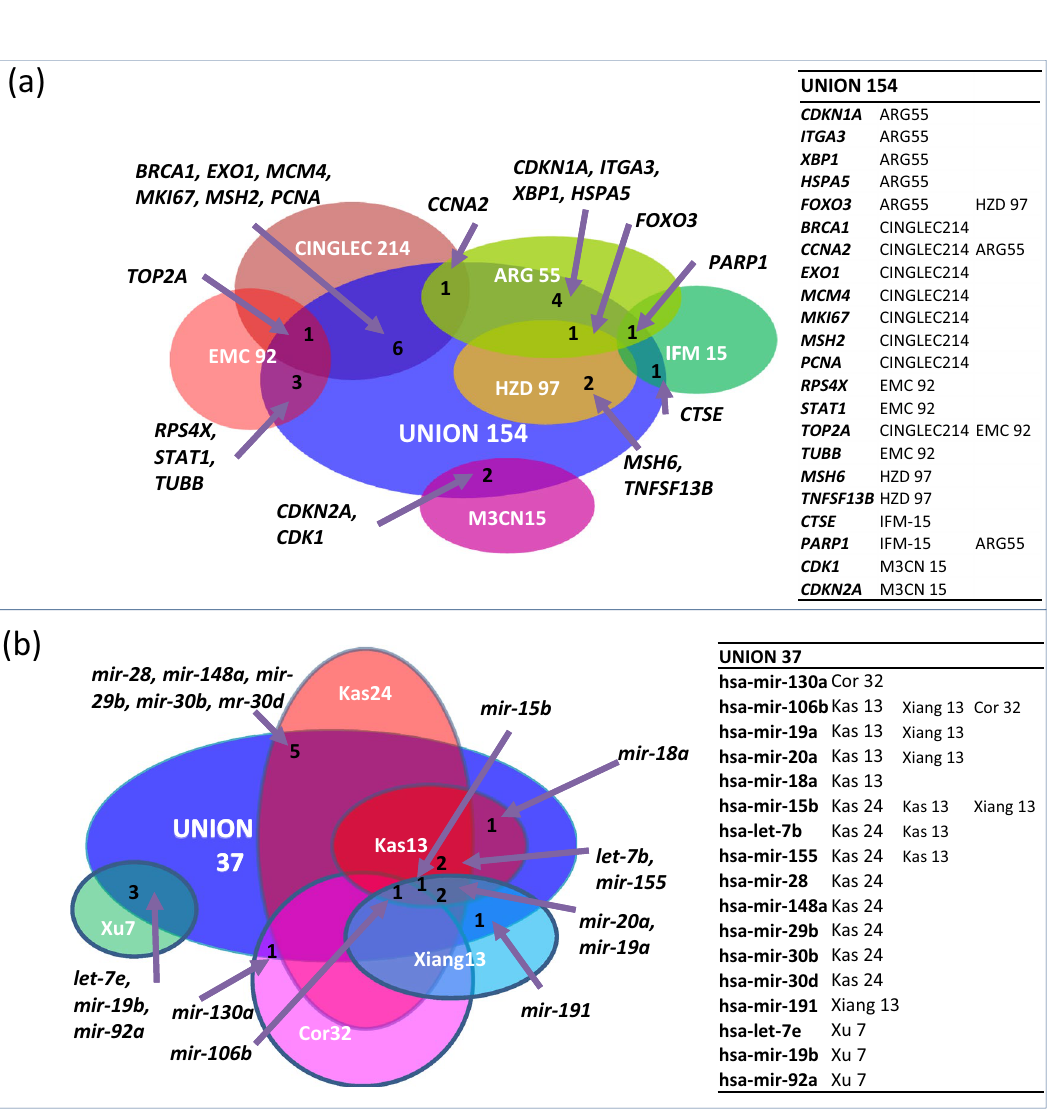
Gene candidates with ≥ 4 biomarker applications. ★